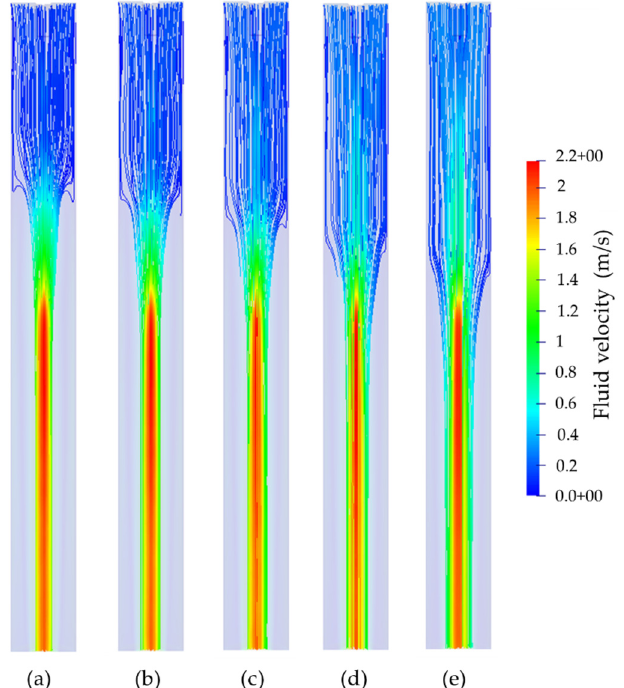
Figure 6. Numerical fluid velocity distributions by using streamline functions under different operating conditions: ( a ) U G = 0.11 m/s; ( b ) U G = 0.15 m/s; ( c ) U G = 0.18 m/s; ( d ) U G = 0.23 m/s; ( e ) U G = 0.27 m/s.